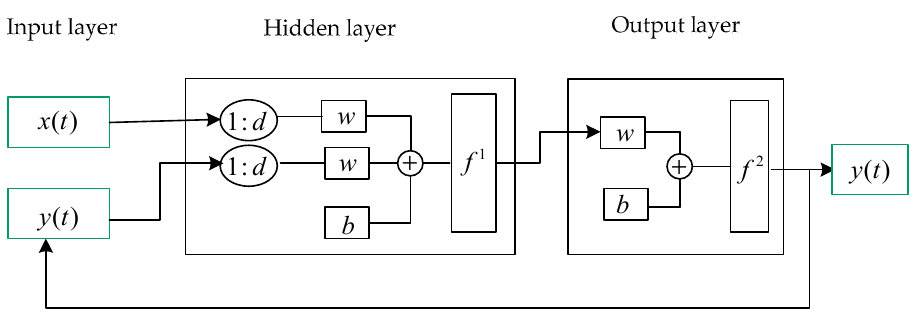
Figure 3. The structure of the NARX neural network.